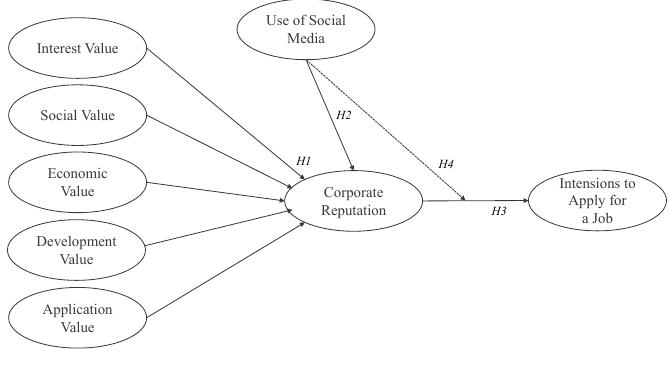
Fig. 1 – A proposed research model. Source: Original model by Sivertzen et al.